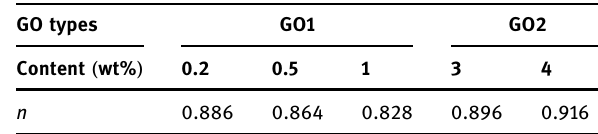
Table 2: Non - Newtonian index of blend solutions with di ff erent GO